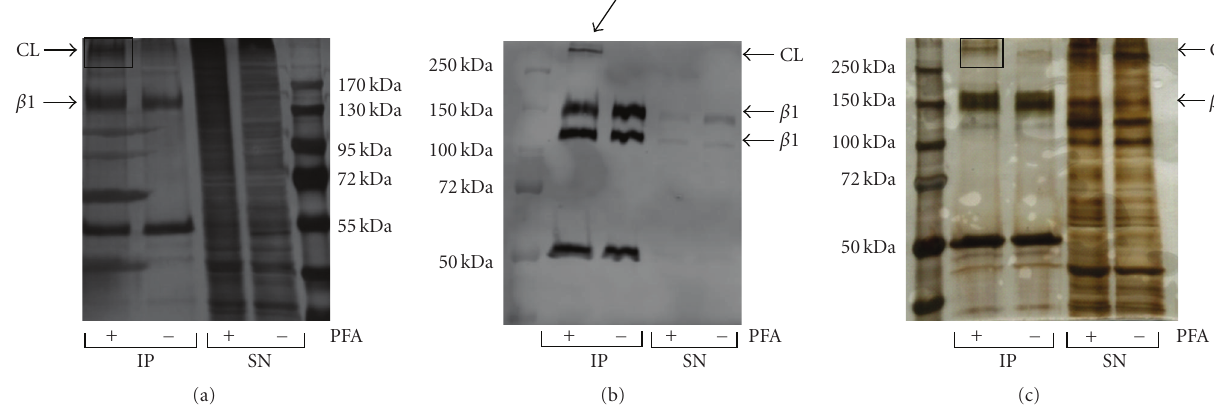
Figure 5: Analysis of integrin β 1 complexes (CL) from Jurkat cells and human platelets. (a) Jurkat cells were treated with or without 0.4% formaldehyde (PFA) before lysis. Immunoprecipitation was performed using 2 mg lysate and 5 μ g of JB1B and analyzed by SDS PAGE. The indicated area was excised and analyzed by mass spectrometry. (b) Anti-integrin β 1 immunoblot (JB1A, anti-mouse Alexa Fluor 680) of JB1B pull-downs performed on human platelets treated with and without 0.4% formaldehyde (PFA). 100 μ g platelet lysate and 0.85 mg JB1B were used. Complexes containing integrin β 1 are indicated by the arrow. (c) SDS PAGE analysis of JB1B immunoprecipitates from noncross- linked and cross-linked human platelets. Immunoprecipitation was performed using 0.7 mg lysate and 4.25 μ g JB1B. The indicated band was excised and examined with mass